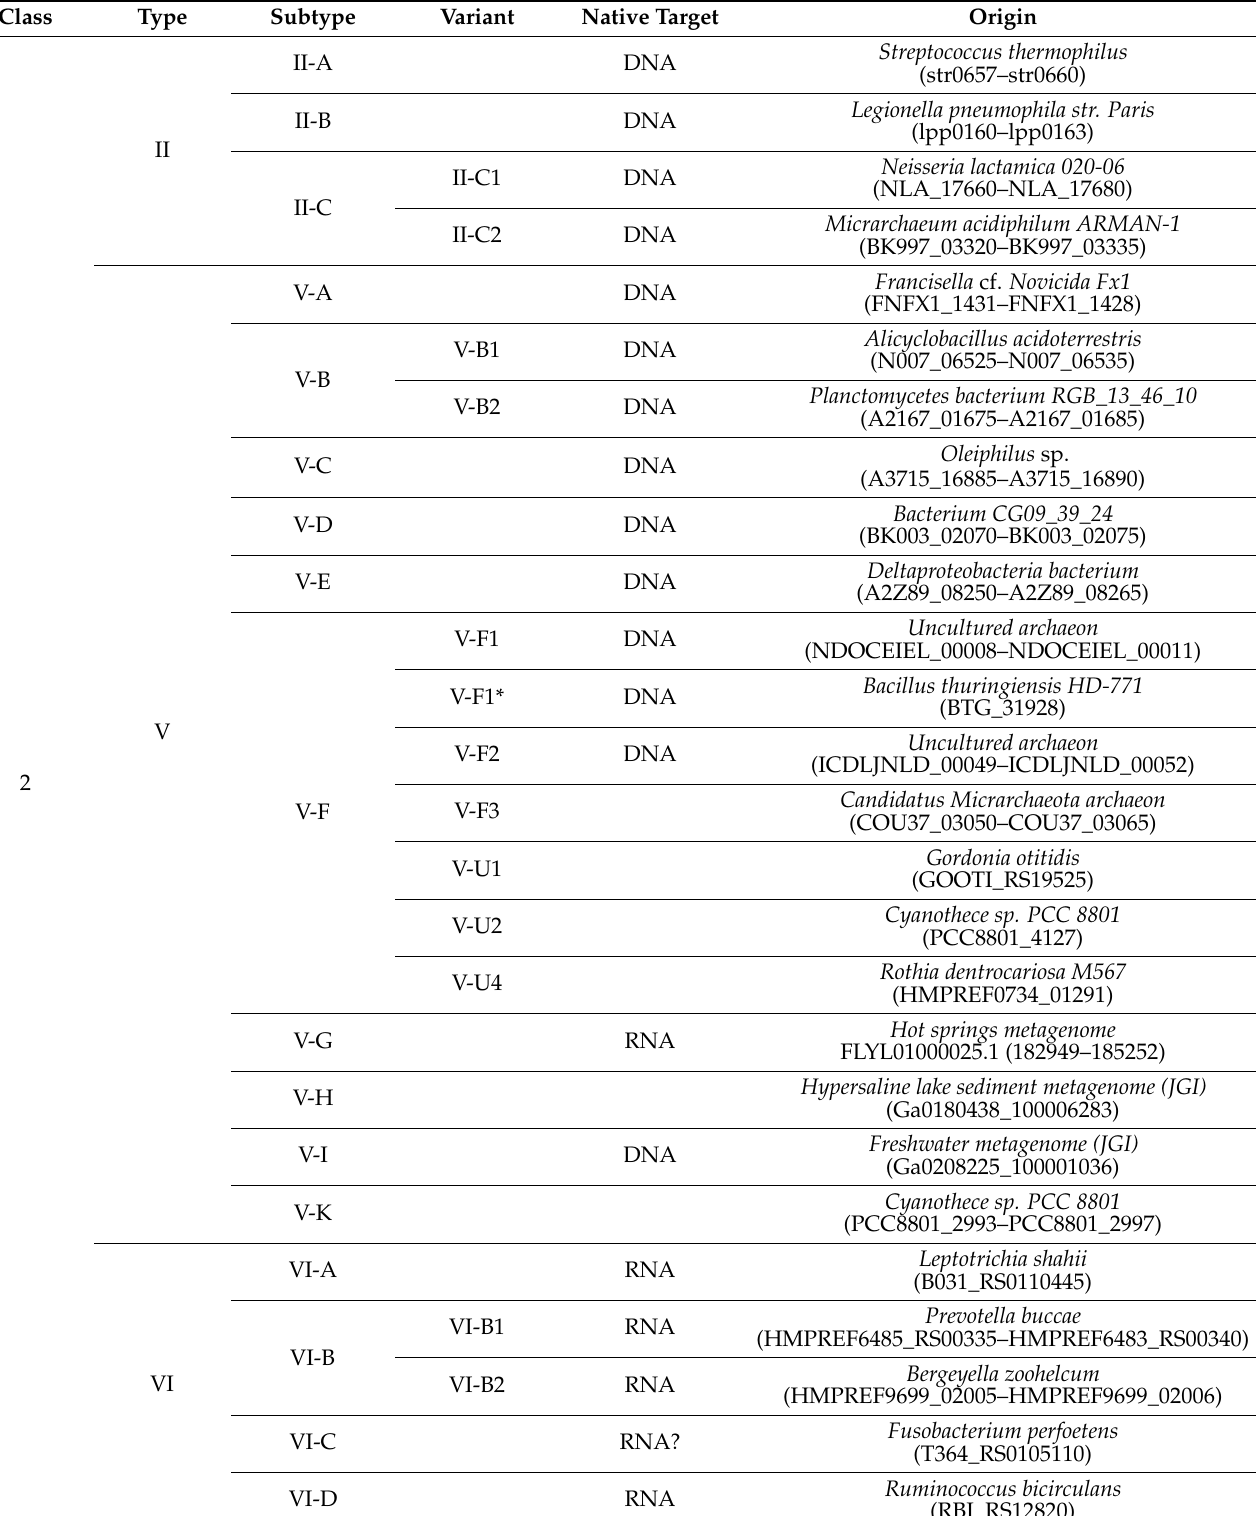
Table 4. Classification of class 2 CRISPR–Cas systems. An asterisk represents a variant that was formerly classified as variant I-U3